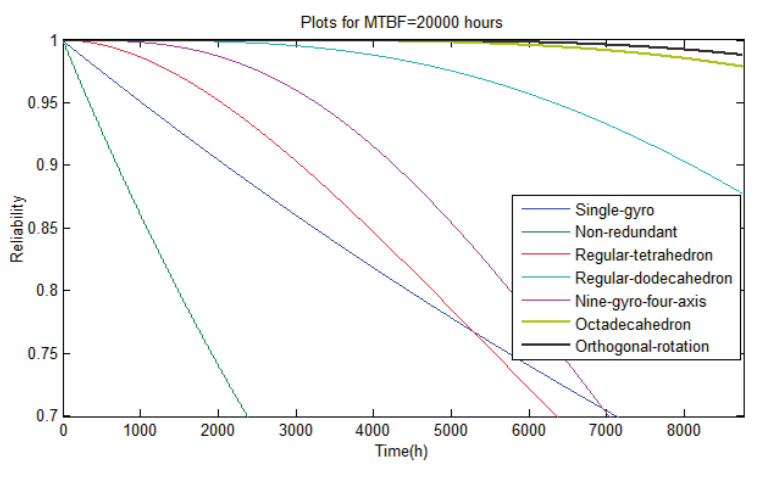
Figure 5. Reliability curves of seven different